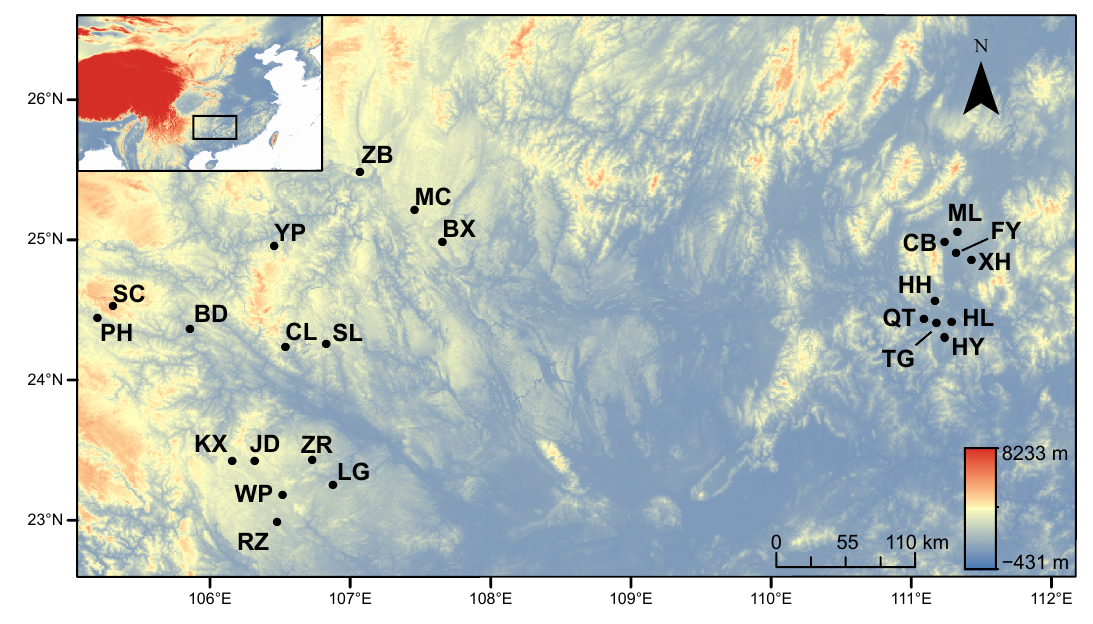
Figure 1. Geographical locations of 24 sampled populations of S. litura . The codes of towns represent different populations. Hezhou city: Mailing (ML), Xinhua (XH), Fuyang (FY), Chengbei (CB), Honghua (HH), Qingtang (QT), Tonggu (TG), Huilong (HL), Huangyao (HY); Hechi city: Baxu (BX), Mangchang (MC), Zhongbao (ZB); Baise city: Badu (BD), Youping (YP), Puhe (PH), Chaoli (CL), Shali (SL), Shechang (SC), Jingde (JD), Zurong (ZR), Longguang (LG), Renzhuang (RZ), Wuping (WP), Kuixu (KX). Table 1. Sampling districts and the number of specimens of S. litura used in this study. City Population Longitude Latitude Sample